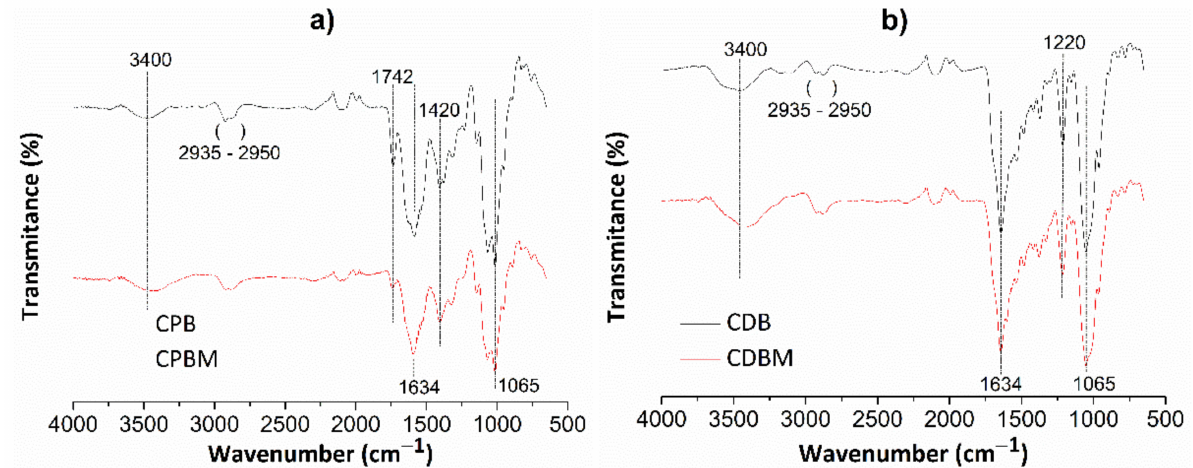
Figure 4. FT-IR spectra for chitosan/pectin ( a ) and chitosan/DNA ( b ) hydrogels without (CPB and CDB, respectively) and with MB (CPBM and CDBM,